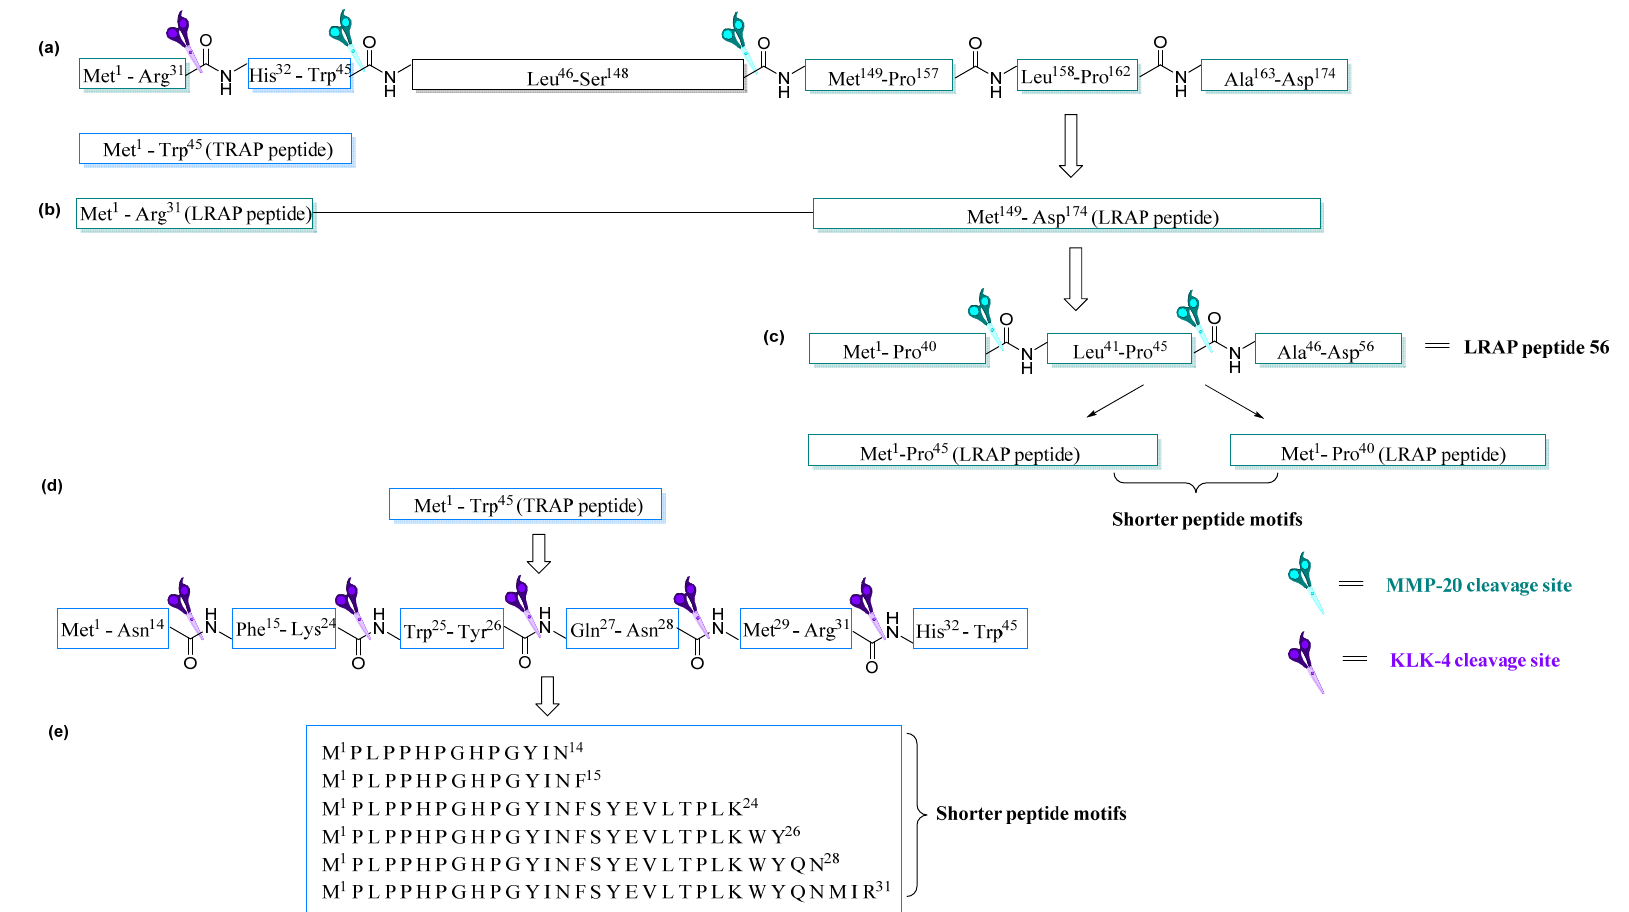
Figure 4. ( a ) Native porcine amelogenin protein indicating its major cleavage sites by KLK-4 and MMP-20 protease generating TRAP and LRAP peptide ( b ) cleaved N-terminal segment and C-terminal segment giving rise to LRAP ( c ) LRAP peptide is further cleaved by MMP-20 to generate shorter motifs of LRAP of 45 and 40 amino acid residues ( d ) TRAP peptide is further cleaved by KLK-4 protease to generate shorter motifs of TRAP peptides ( e ) Amino acid sequence of KLK-4 generated TRAP